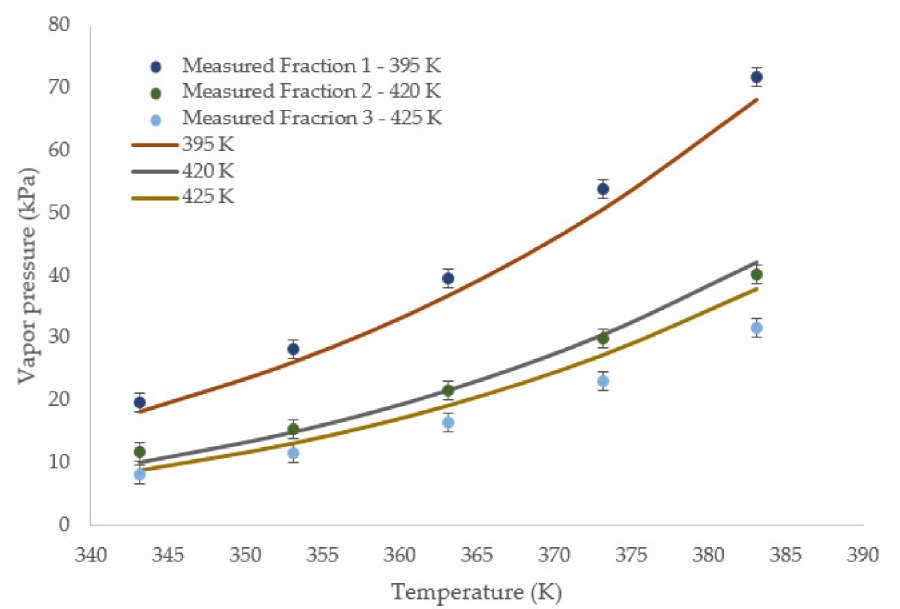
Figure 5. Comparison of measured and calculated vapor pressure of several gasoline fractions. The values in legends are temperature in Kelvin. Error bar shows expanded uncertainty (95% confidence level, k = 2) of measured vapor pressure